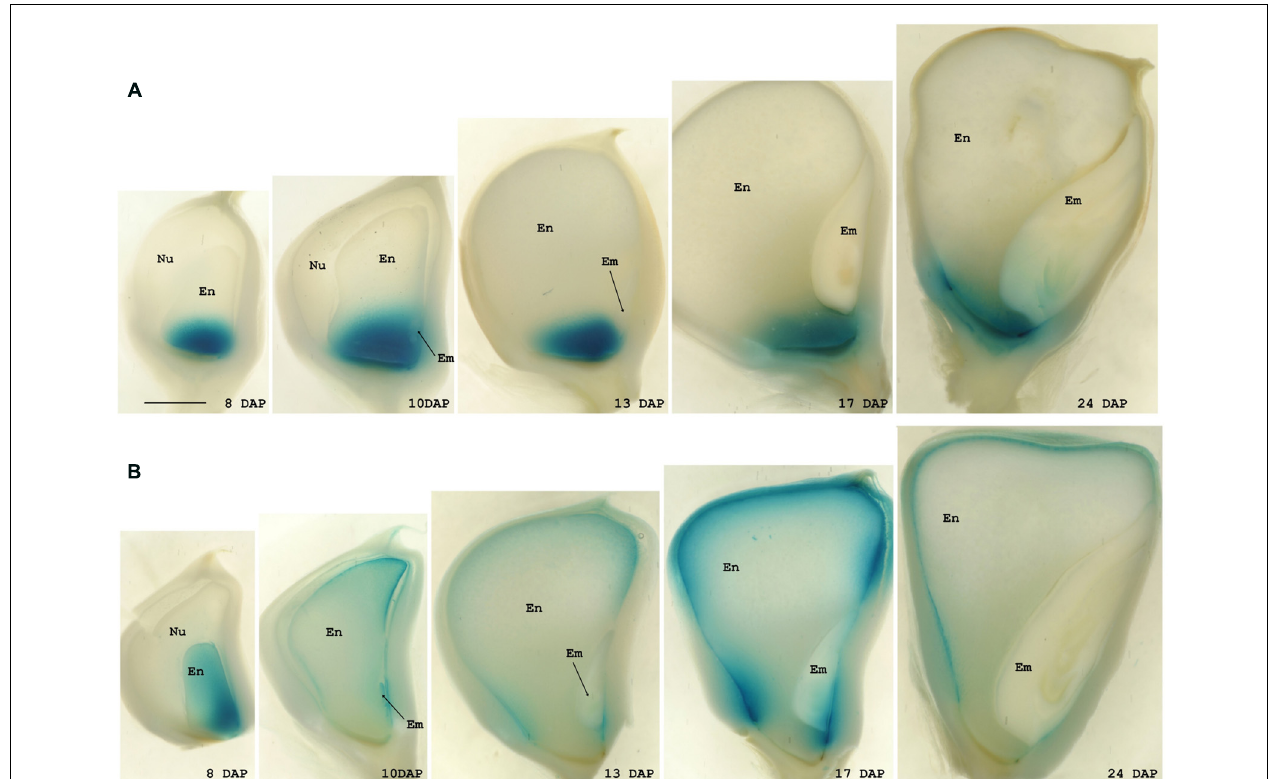
FIGURE 4 | Expression analyses of the BETL9 and BETL9like promoters. Histochemical analyses for GUS expression in maize kernels. Positive expression is seen as a blue precipitated. The age of the kernels is indicated as days after pollination. The promoters